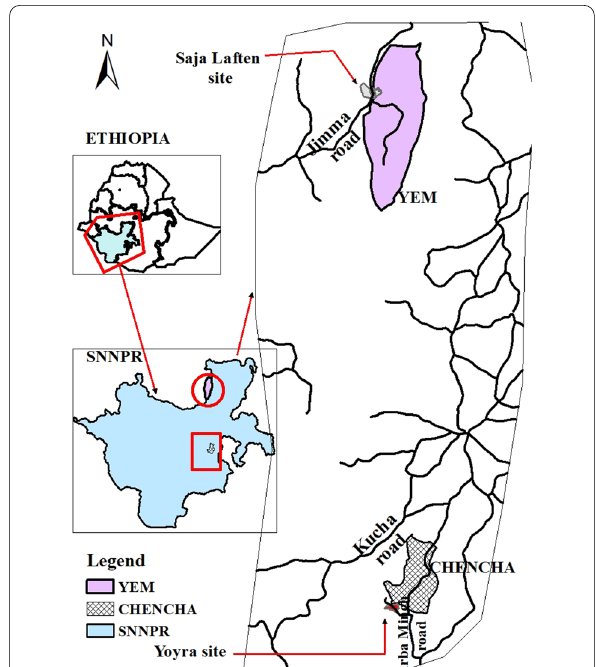
Fig. 1 A map showing the study sites